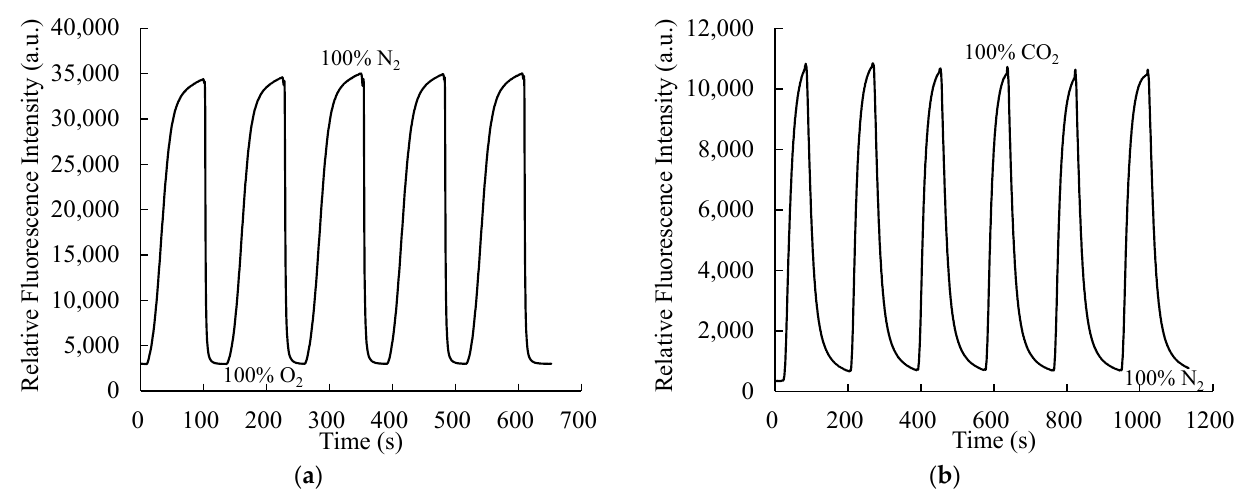
Figure 6. Response and recovery plots of the optical dual sensor for ( a ) O 2 and ( b ) CO 2 .